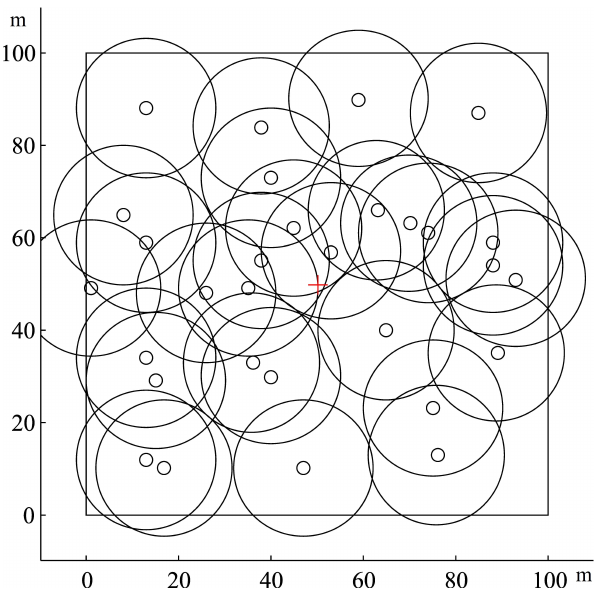
Figure 5. Senario of SN and RN deployment within 100 × 100 m 2 .